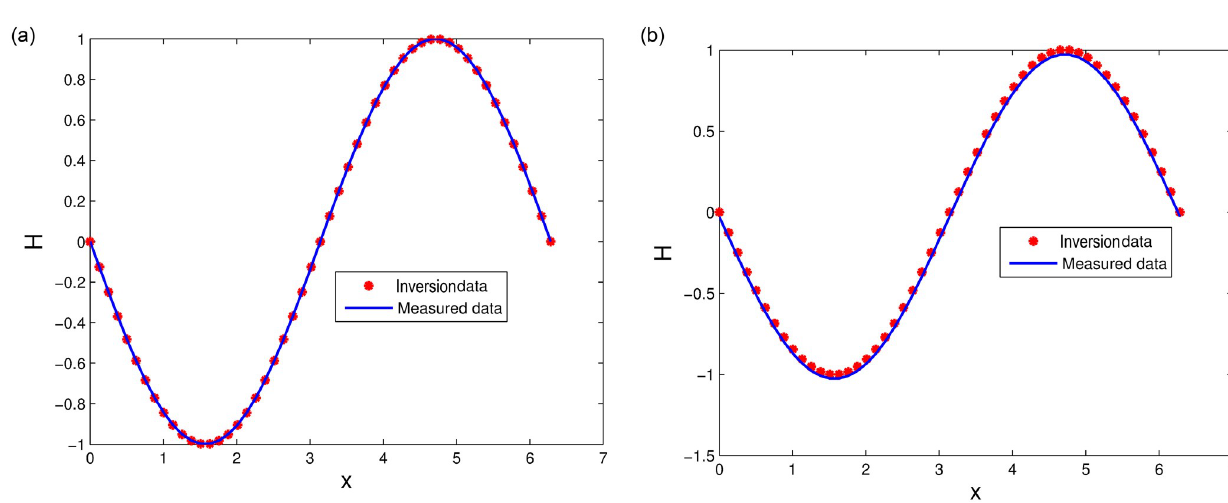
Fig 8. Measured data and inversion data under disturbance σ = 0.004 (left) and σ = 0.04 (right).